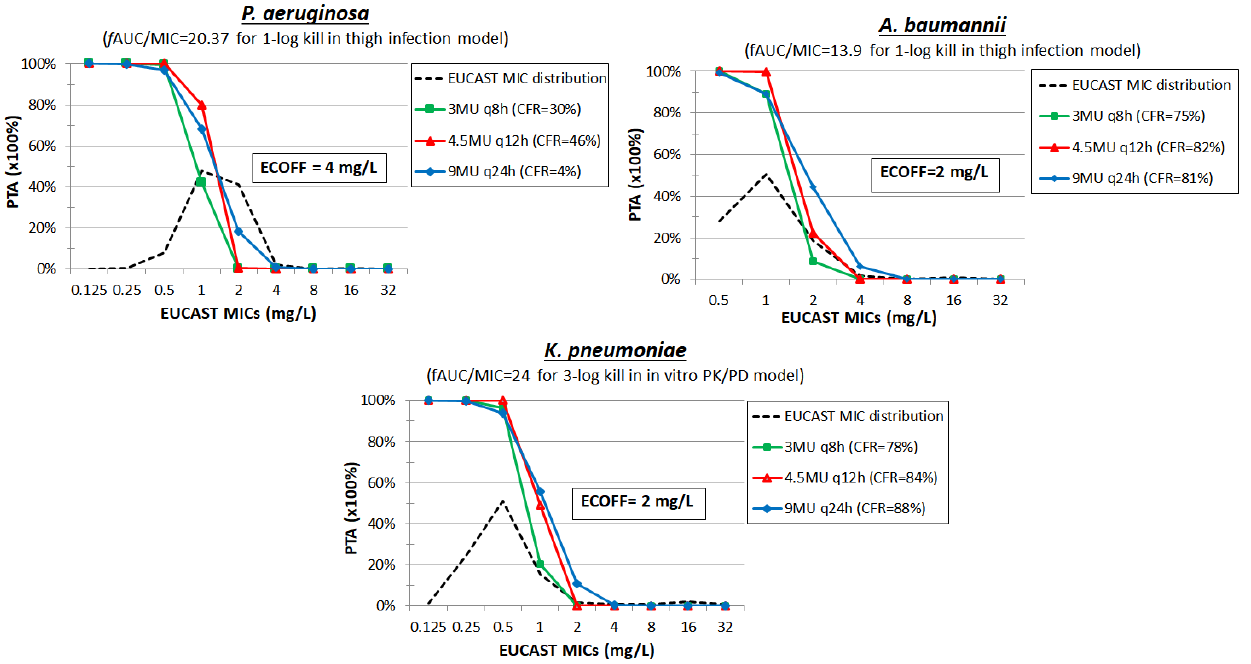
Figure 1. Probability of target attainment (PTA) of colistin at different dosing regimens against iso- lates with increasing MIC. The cumulative fraction of response (CFR) is shown for a collection of isolates with the EUCAST MIC